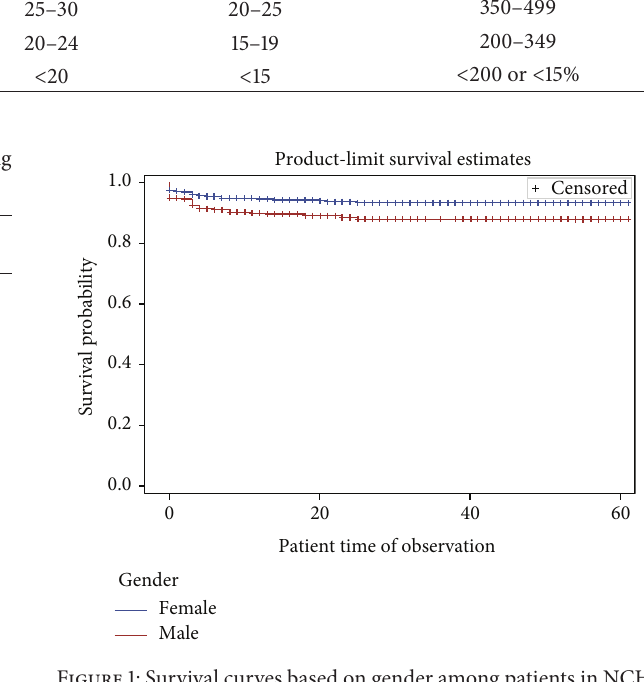
Figure 1: Survival curves based on gender among patients in